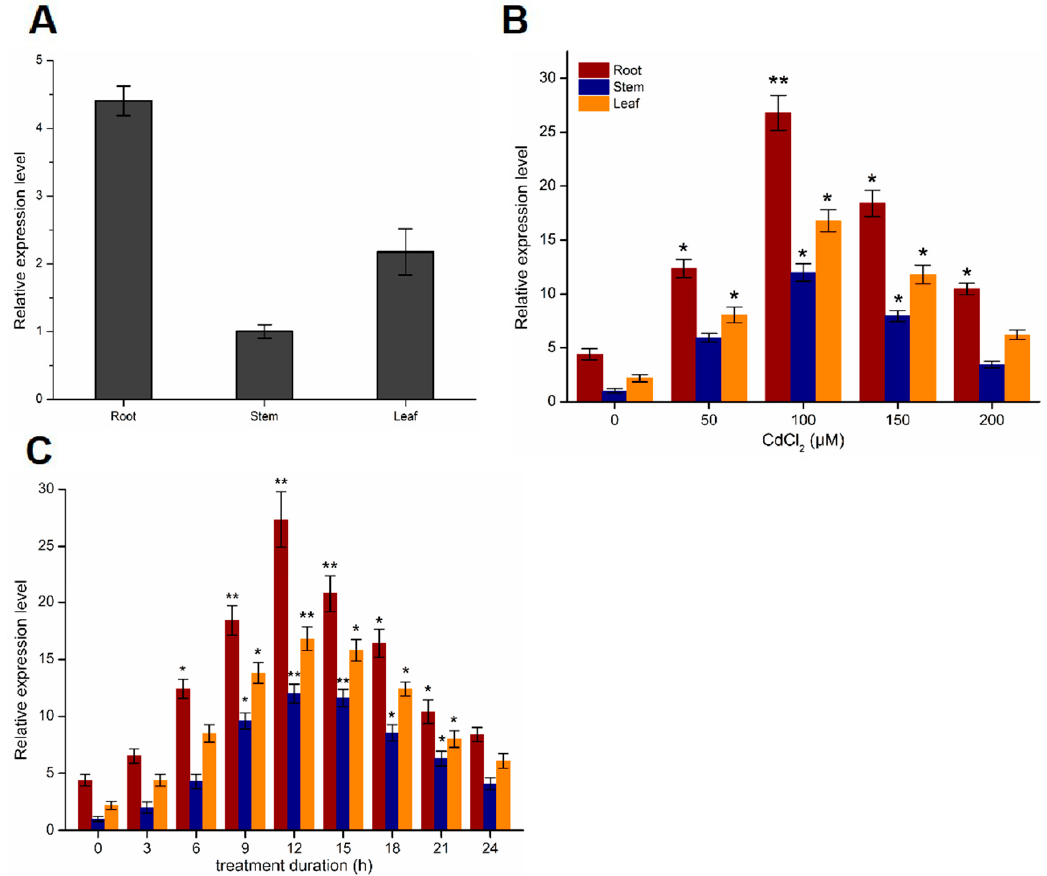
Figure 2. Expression analysis of PtoABCG36 gene. ( A ) Relative expression level of PtoABCG36 gene in roots, stems, leaves of Populus tomentosa . ( B ) Expression of PtoABCG36 in poplar roots, stems and leaves under different concentrations of Cd 2+ for12 h. ( C ) Time course of PtoABCG36 expression in poplar roots, stems and leaves in response to 100 µM Cd 2+ treatment. The results are shown as the mean expression ± standard deviation (SD) of three independent experiments. Poplar ubiquitin ( UBQ ) expression was used as a control and gene-specific primers were used for qRT-PCR analysis of PtoABCG36 gene. Student’s t-test, * p < 0.05, ** p <